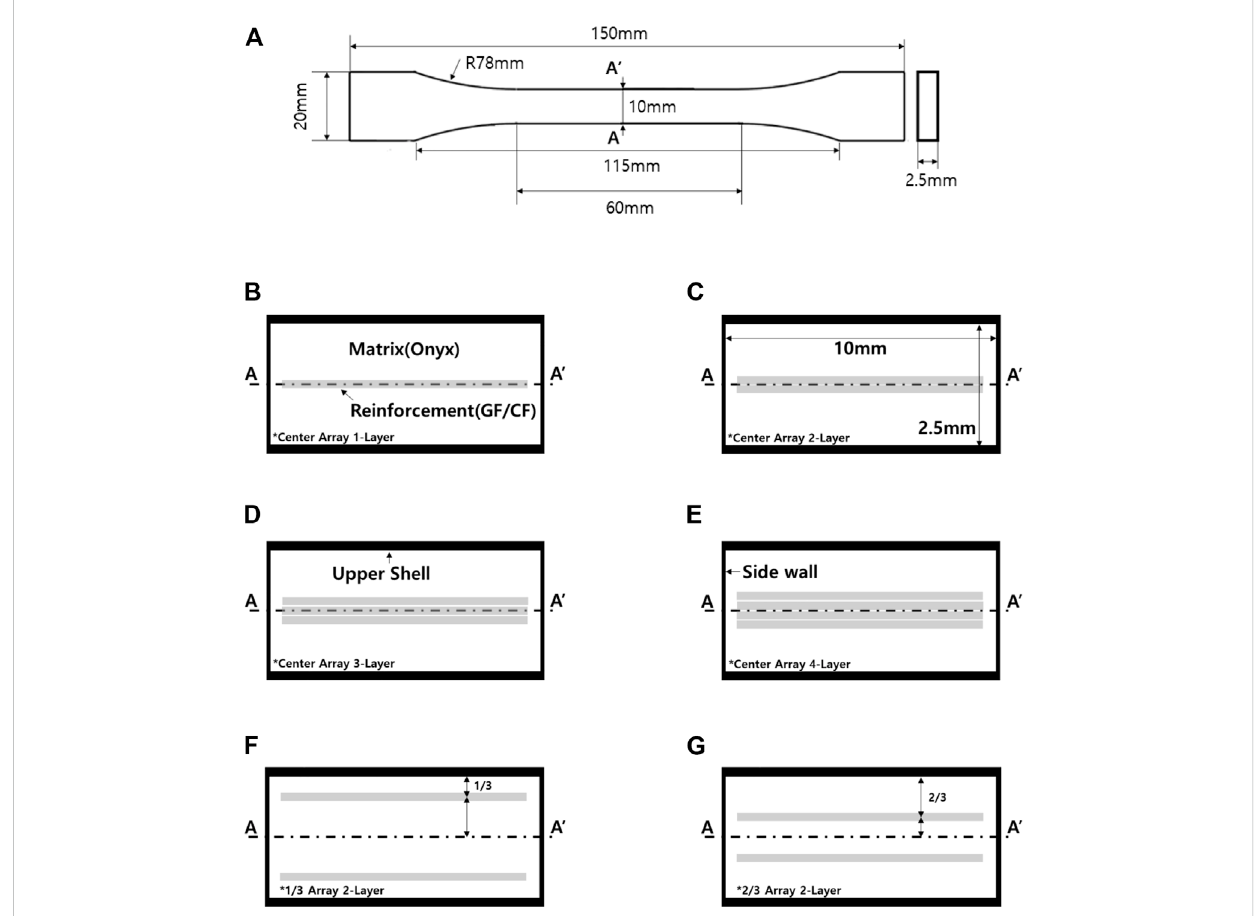
FIGURE 1 Compositespecimen geometryand cross section. (A) Tensiletestspecimenshape, (B) 1-layerreinforcement, (C) 2-layer reinforcement, (D) 3-layer